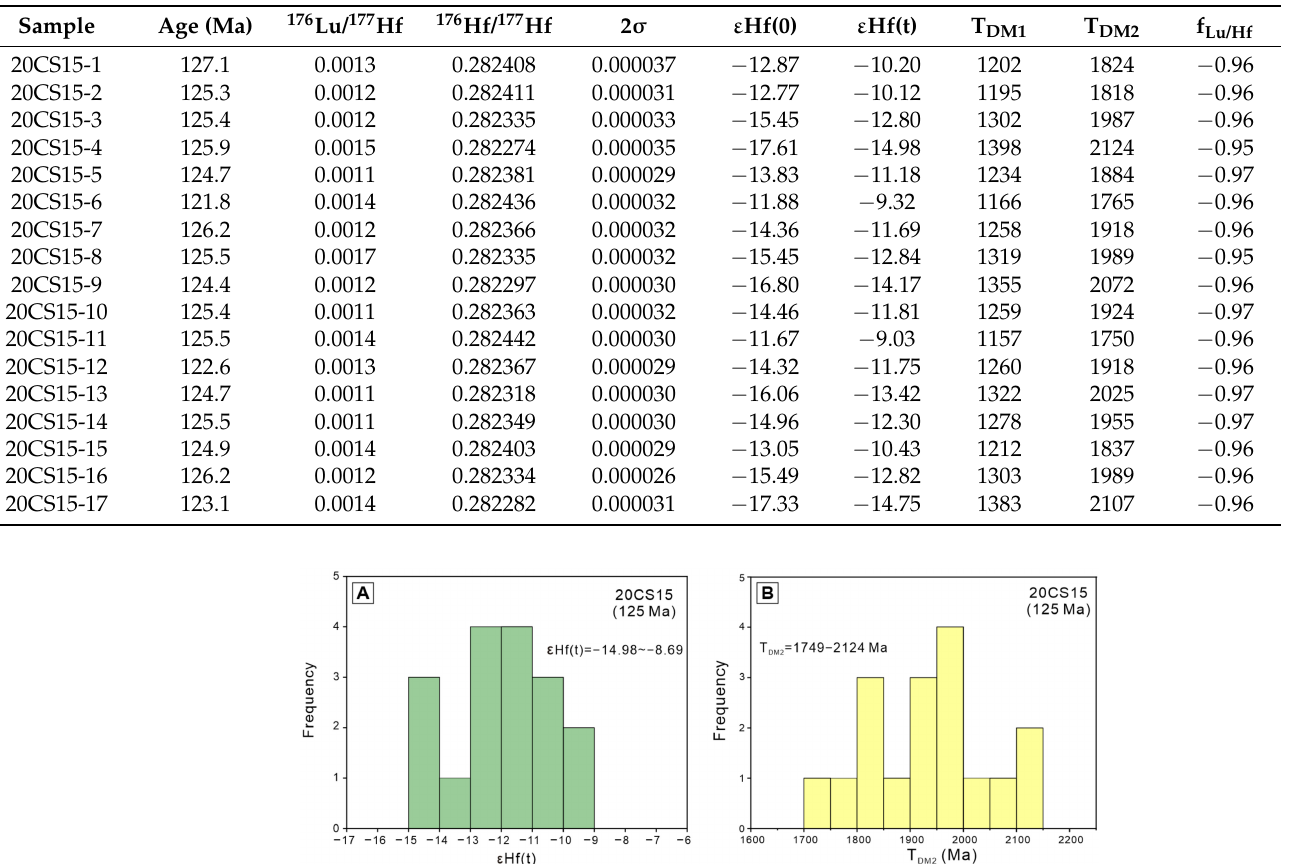
Figure 9. ( A ) Histogram of zircon ε Hf(t) values for the lamprophyre (20CS15). ( B ) Histogram of two-stage-model age for the lamprophyre.